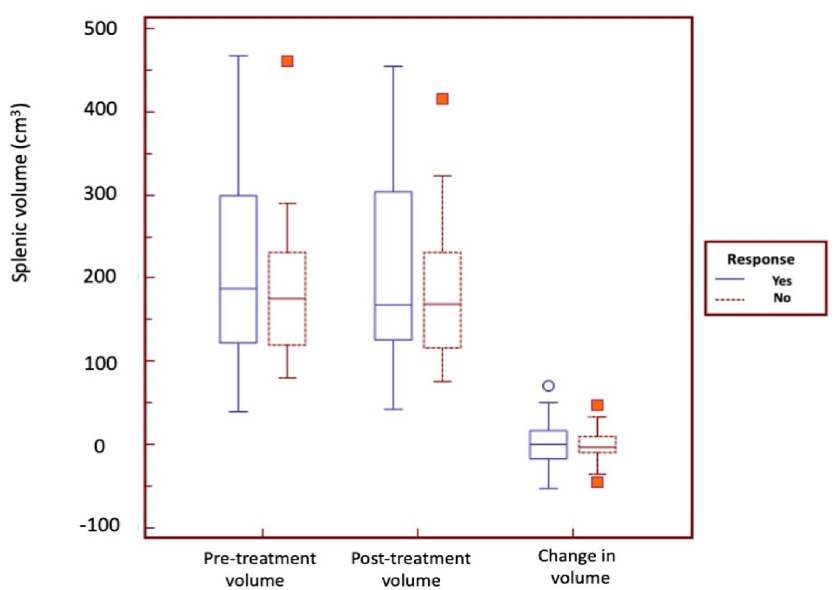
Fig 3. Splenic volume does not show significant changes in responders and non-responders. The boxplots show the median pre-treatment splenic volume, post-treatment splenic volume or change in splenic volume between responders and